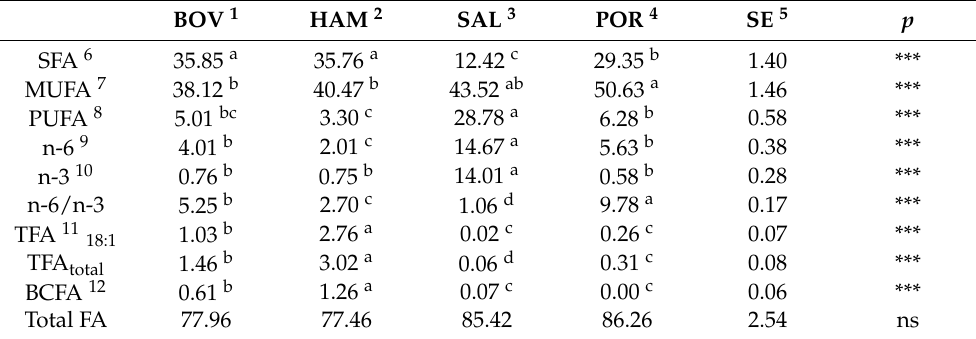
BOV 1 HAM 2 SAL 3 POR 4